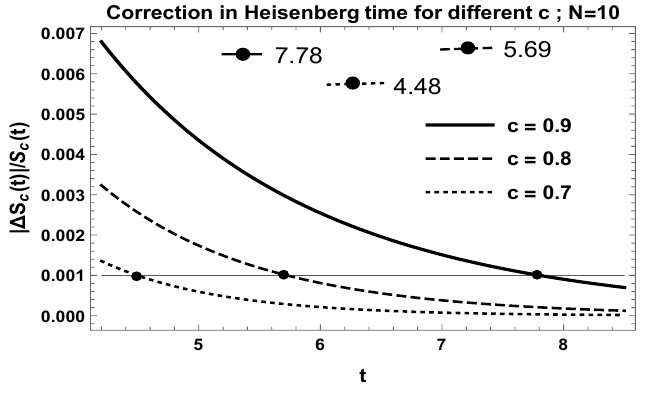
Figure 11 . Relative fluctuation defined in eq. (3.6) for SFF average at N = 15 , 10 , c = 0 . 9 w.r.t. t is obtained using eq. (3.6) with ∆ t = 0 . 1 .